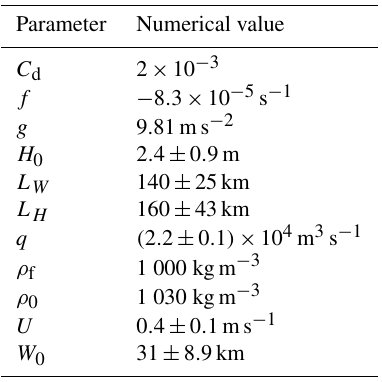
Table 4. Parameter values used to evaluate Eqs. (13) and (29). See Appendix B for a detailed discussion on how the numerical values of the model parameters were